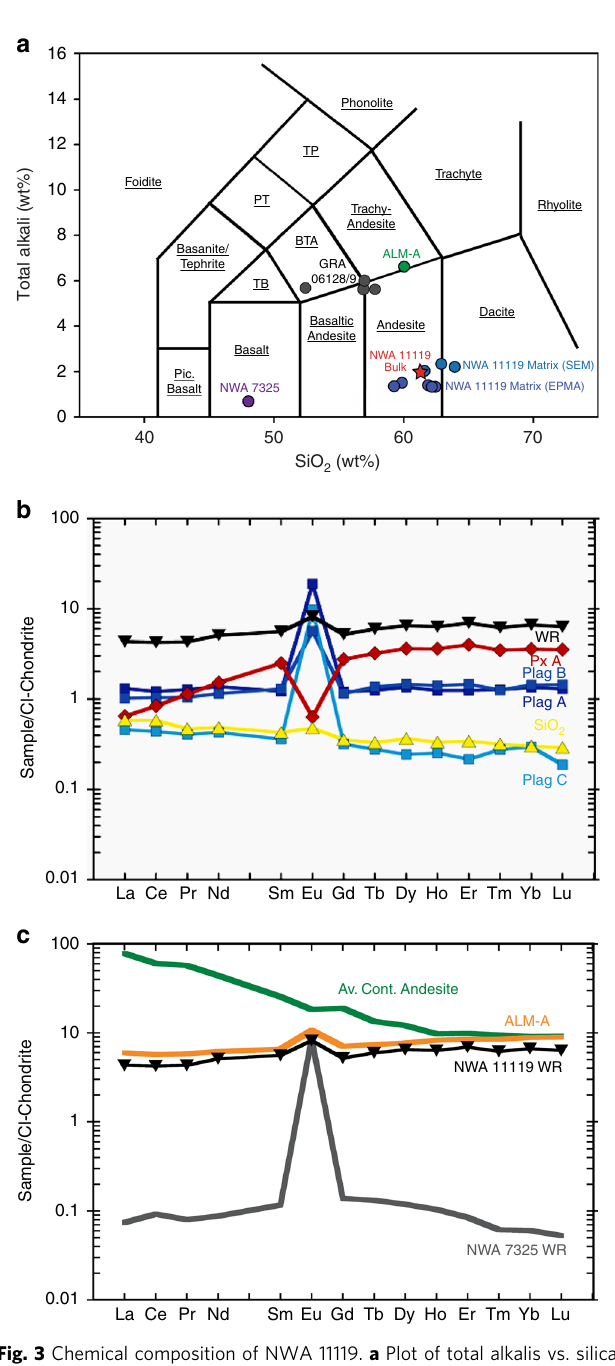
Fig. 3 Chemical composition of NWA 11119. a Plot of total alkalis vs. silica content showing the compositions of the bulk and matrix of NWA 11119. The bulk rock has low alkali content, and measured values for the matrix show an evolved andesitic/dacitic composition. For comparison, bulk compositions for ALM-A and NWA 7325 are also shown. b CI-normalized rare earth element (REE) abundances in the NWA 11119 whole rock (WR) and mineral separates (Px = pyroxene; Plag = plagioclase; SiO 2 = Silica). c Comparison of CI-normalized REE abundances in whole rocks of NWA 11119 (black inverted diamonds), ALM-A (orange), NWA 7325 (gray), and average continental andesite (green). Compositional data for ALM-A from ref. 3 , NWA 7325 from refs. 21,39 , average continental andesite from ref. 54 , and CI chondrites from ref. 55 Errors on our REE data (2 sigma) are typically ±10% and are smaller than the data points